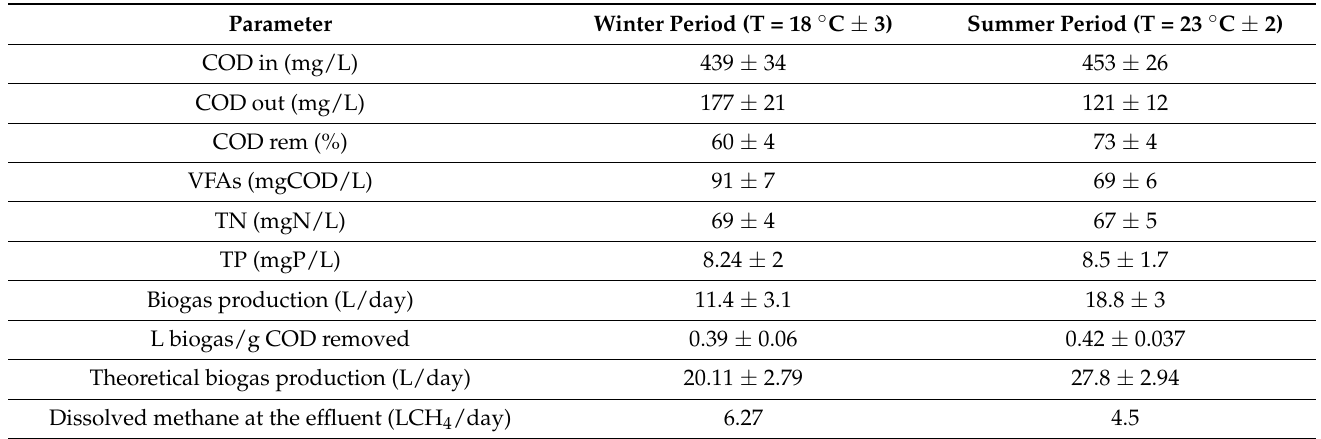
Table 5. Aggregated results ( ± standard deviation) for AnMBR operation at 6 h HRT with no iron